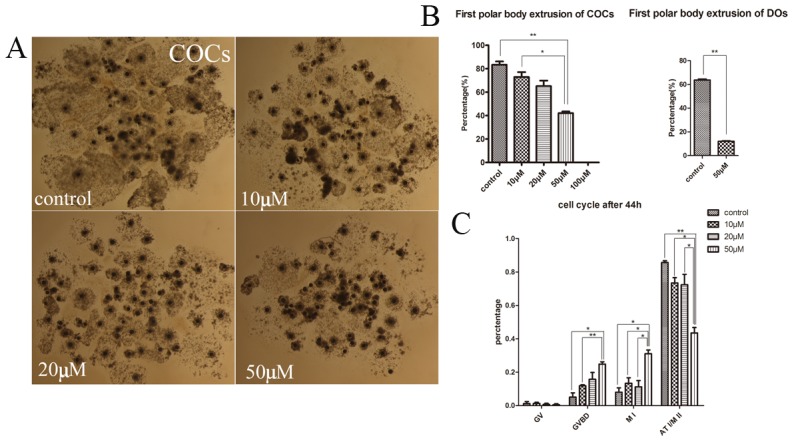
Disrupting KIF20A activity inhibits the meiosis competence and cell cycle progression of porcine oocytes.(A) Granulosa cell diffusion of COCs was inhibited during meiosis. Almost all of COCs in control groups were surrounded by more than 5 layers of intact cumulus cells, whereas the COCs in 10, 20 and 50 µM Paprotrain treatment groups showed weakened diffusion. (B) Rates of first polar body extrusion of porcine oocytes after 44 h culture with different treatments (Control, 10 µM, 20 µM, and 50 µM). Oocytes failed to extrude the first polar body after treatment with KIF20A inhibitor. * significant difference (p<0.05). (C) Effects of KIF20A disruption on cell cycle during oocyte meiosis maturation. The cell cycle progression of porcine oocytes was disturbed during meiosis. The oocytes arrested at GVBD or MI stage and cannot perform the proper progression of cell cycle after KIF20A disruption. * significant difference (p<0.05).